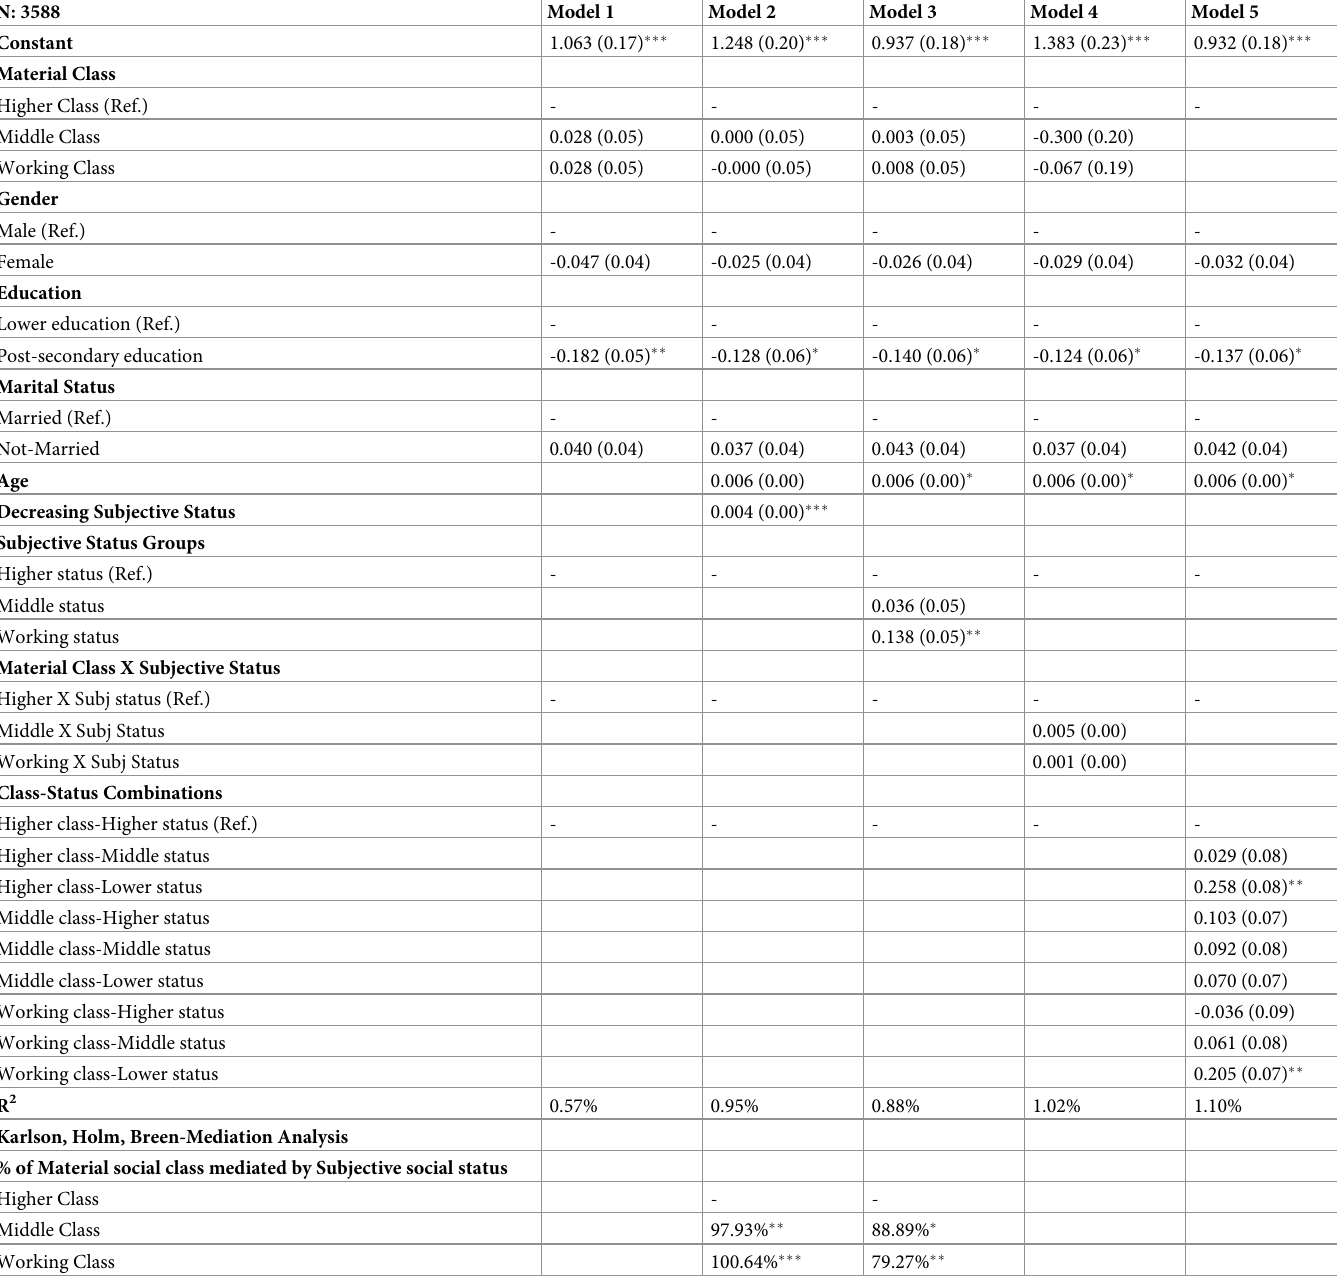
Table 1. Material class and subjective social status regressed on health biomarkers with control